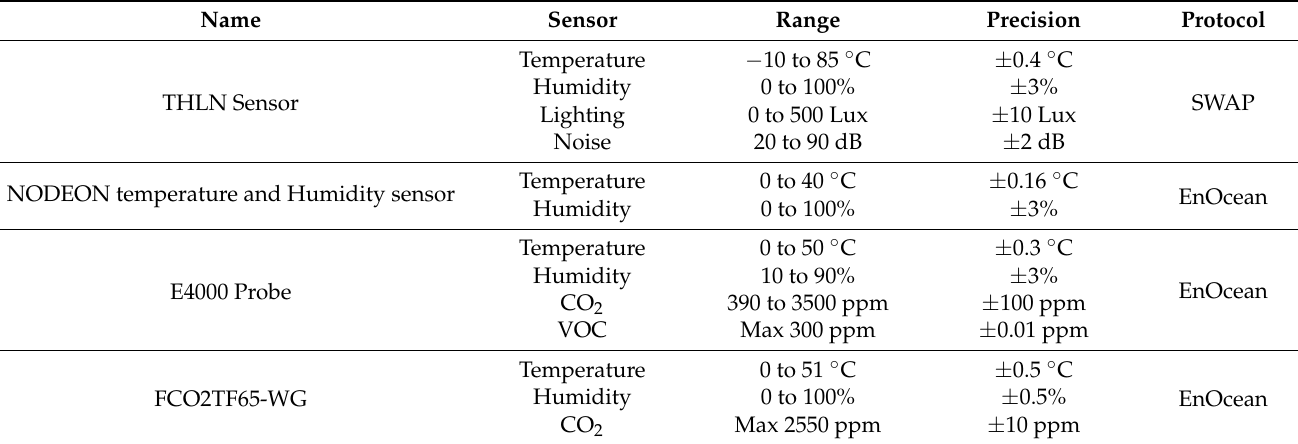
Table 2. Technical specifications of the comfort sensors.